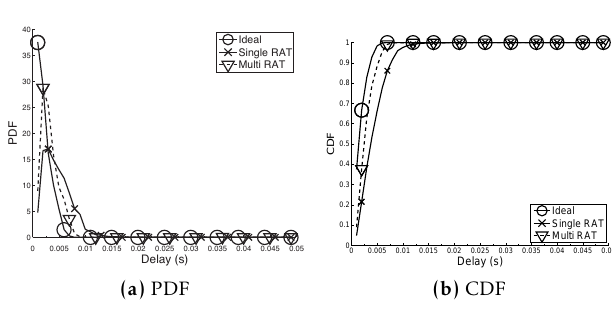
Figure 13. Video Frame End-to-End Delay